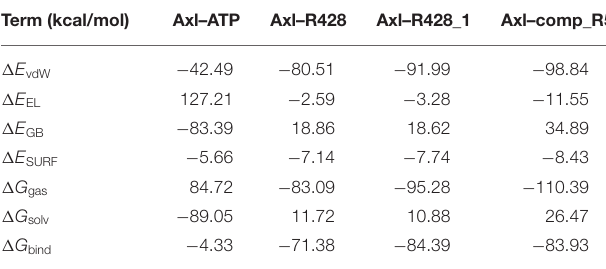
TABLE 9 | Energetic analysis of the receptor–ligand complexes using the MM-GBSA implicit solvation model.